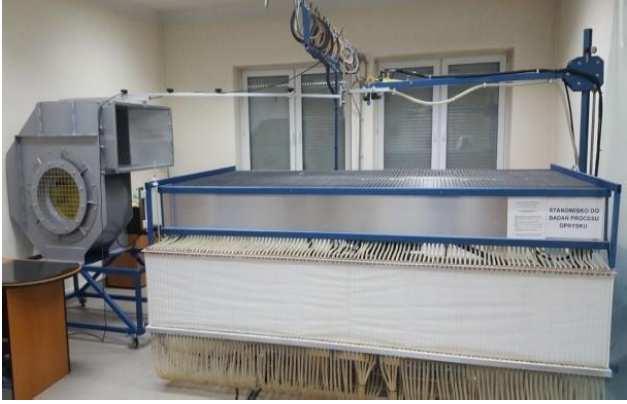
Figure 1 . View of the spraying process testing stand . Figure 1. View of the spraying process testing